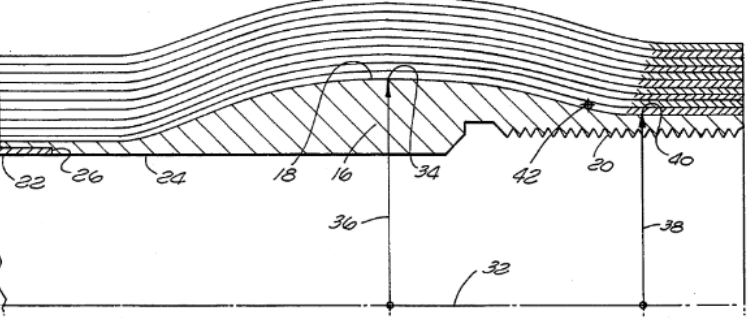
Figure 11. A form-fit connection of liner and composite overwrap shown in US5415079A [50]. Patent US5435868A [51] describes a method of manufacturing composite barrels with internal threads at the ends using the filament winding method (Figure 12). It uses a cylindrical core with threaded inserts (36) placed on it. The barrels (10), with smooth parts (12) and threaded parts (20), (22) are produced by a winding process and separated from each other by distances (58). After the process, the core is pulled from the center and the threaded inserts are unscrewed from the barrels. In this way, the outer thread contour of the inserts is transferred to the inner thread of the composite barrel. The advantage of this method is that it can produce multiple elements on a single